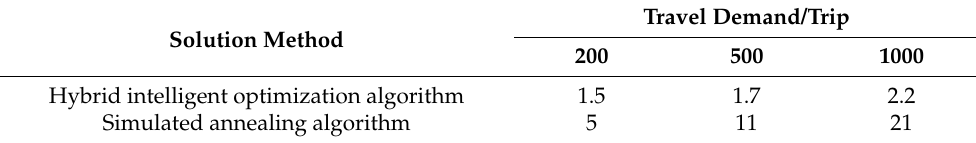
Table 5. Comparison of operation time comparison